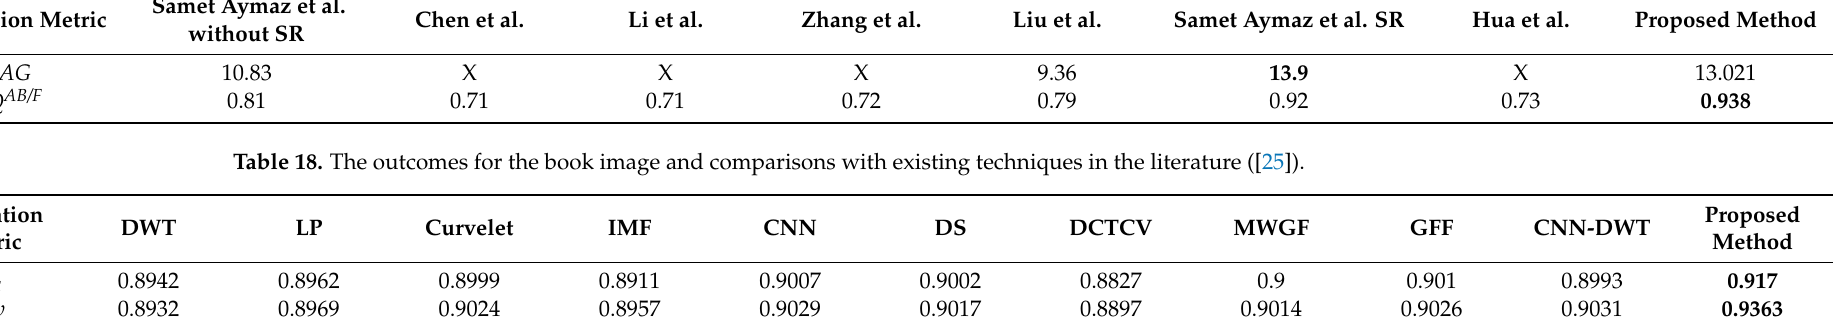
Table 17. The outcomes for the book image and comparisons with existing techniques in the literature ([24]).